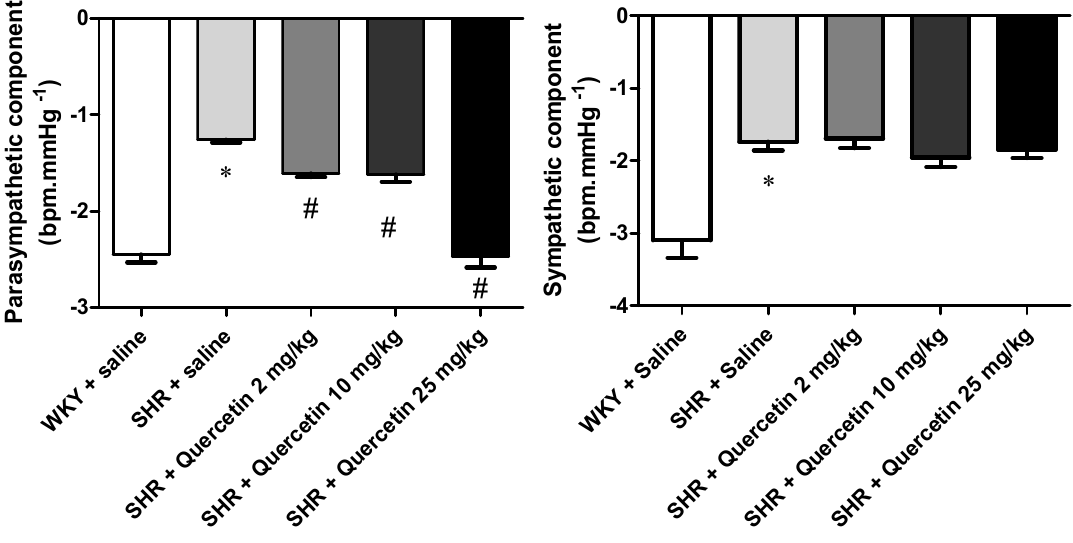
Figure 3. Parasympathetic and sympathetic components of the baroreflex in WKY + saline (n = 8, open bar), SHR + saline (n = 9, light grey bar); SHR + Quercetin 2 mg/kg (n = 7, medium grey bar); SHR + Quercetin 10 mg/kg (n = 8, dark grey bar) and SHR + Quercetin 25 mg/kg (n = 8, black bar) groups. * p < 0.05, when compared to WKY + saline group and # p < 0.05, when compared to SHR + saline